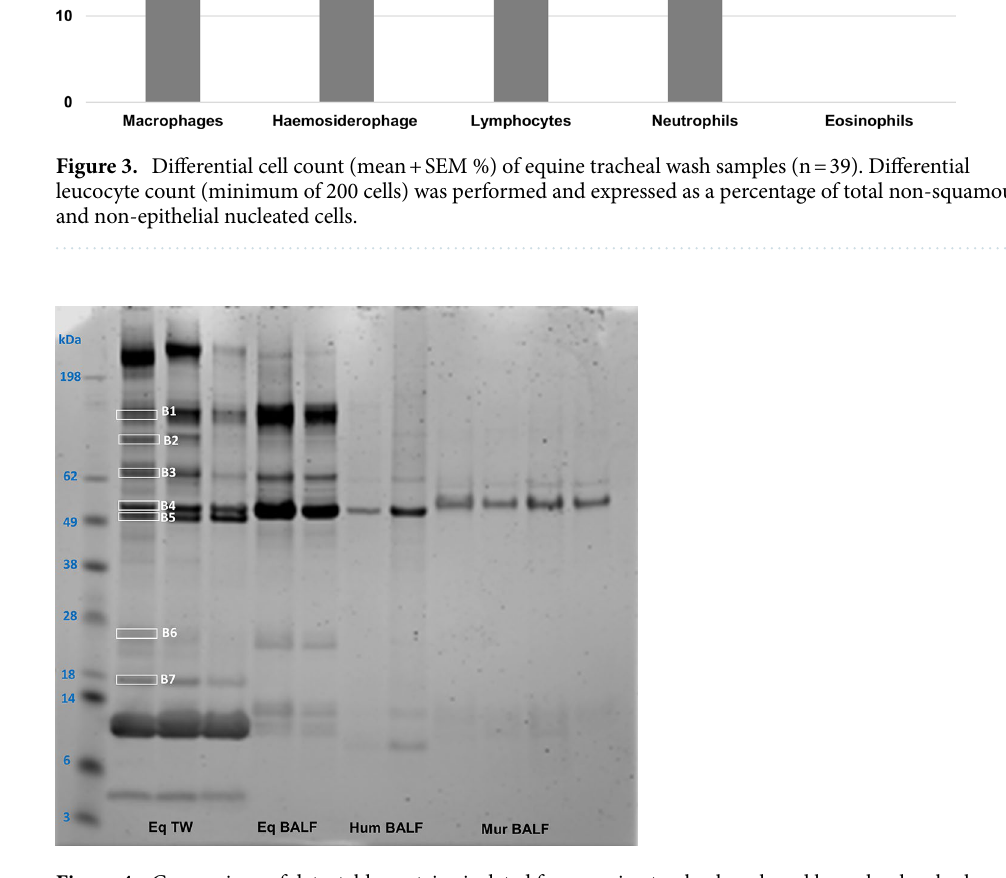
Figure 4. Comparison of detectable proteins isolated from equine tracheal wash and bronchoalveolar lavage samples of human, mice and horse. Lane 1 shows the protein ladder. Total protein stain of equine (Eq) TW samples (Lanes 2–4, 10 ug) and BALF samples (Lanes 5–6, 10 ug). Lanes 7–8 (5 ug) show total protein stain from human (Hum) BALF samples and lanes 9–12 (5 ug) contain total protein stain of four murine (Mur) BALF samples. Selected prominent bands isolated from the gel and analysed in the Mass Spectometry Facility are shown in white boxes (Lane 2, B1–B7). Note the increased diversity of proteins derived from equine TW samples compared to BALF. The stained gel was imaged using the LICOR Odyssey imager and the associated Image Studio Software (https:// www. licor. com/ bio/ odyss ey- fc/, https:// www. licor. com/ bio/ image- studio- lite/, Version